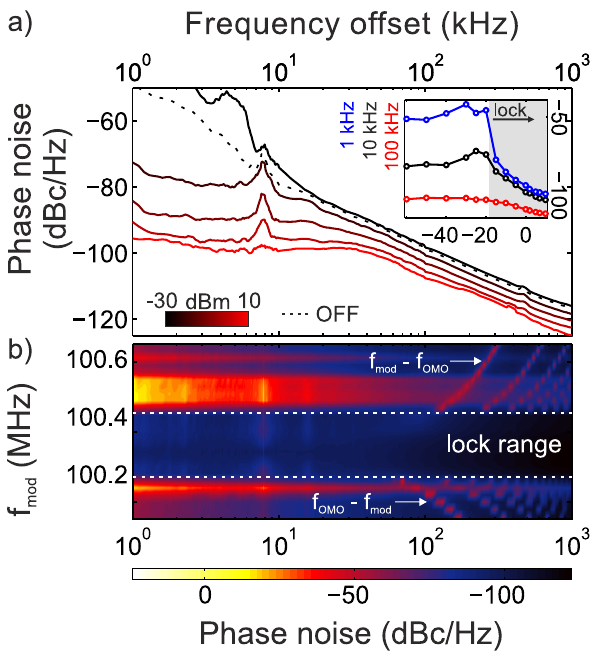
Figure 5: Phase noise characteristics. (Color online) (a) Phase noise measurements of the phonon lasing state with a radio-frequency external tone at f mod ≈ f OMO , 0 . The locked (unlocked) states are represented with black to red curves (dashed black line). The evolution of the phase noise at offsets 1, 10 and100kHzasafunctionofthemodulationpower P VNA aredepicted in the inset, with the lock power range in shaded gray. (b) Color plot of the phase noise as a function of the frequency offset for multiple driving frequencies f mod . The chosen range for f mod covers the full Arnold tongue for a drive power of P VNA = − 10